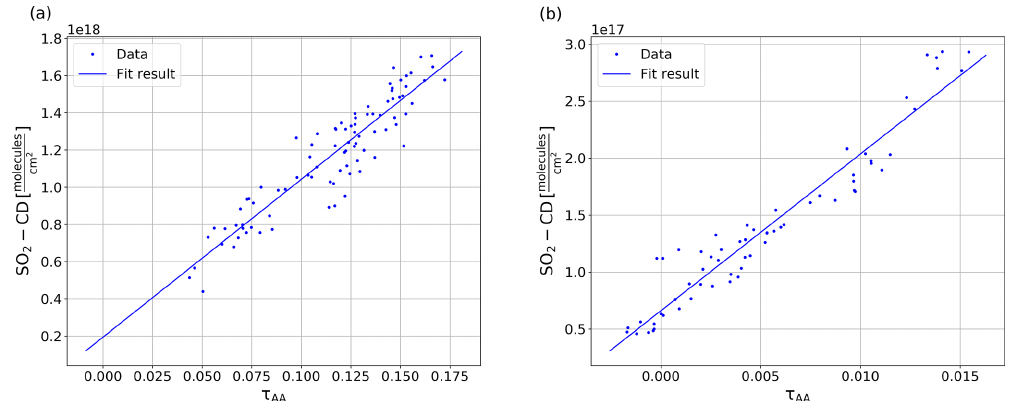
Figure B1. DOAS calibration curves of Etna data (a) and Guallatiri data (b) retrieved from AA images (not dilution corrected) within the image region covered by the DOAS-FOV (cf. Figs. 1 and 2). The corresponding SO 2 -CDs retrieved with the DOAS instrument are plotted on the y axis. Y axis offsets were corrected for during the calibration of the AA images. Table B1. Applied settings for Farnebäck algorithm (OpenCV implementation) and relevant parameters for the histogram post-analysis. Parameter Etna Gua Description 0.5 Multi-scale analysis: downscale factor Multi-scale analysis: pyramid levels winsize Size of (Gaussian) averaging neighbourhood Size of neighbourhood for polynomial